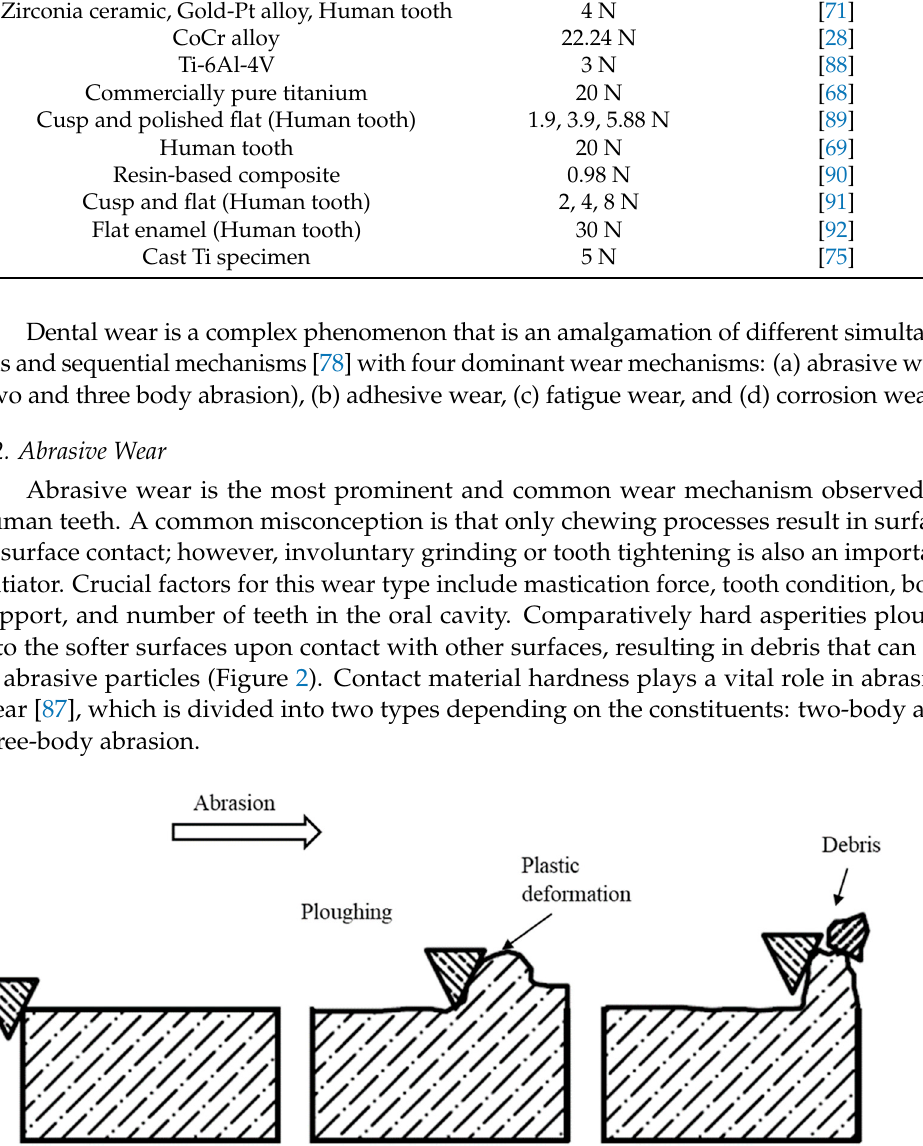
Figure 2. Schematic diagram depicting abrasive wear mechanisms.